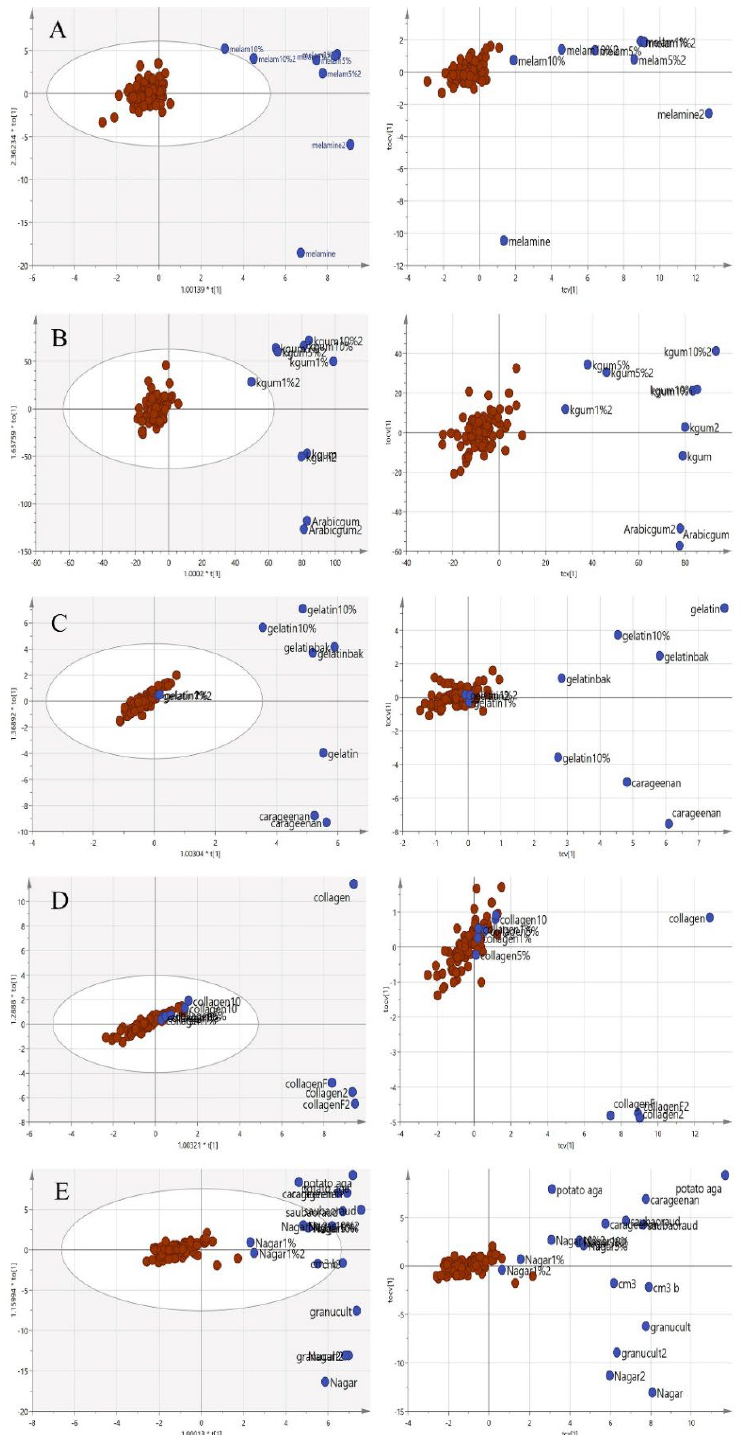
Figure 13. The OPLS-DA and CV score plot of two-class classification using MIR spectra (( A ) melamine, ( B ) karaya gum, ( C ) gelatine, ( D ) collagen and ( E ) nutrient agar). The score model demonstrated that the model was stable and significant, as there was a clear separation of samples, although there was a mild overlap between the two classes (authentic: , non-authentic: ).